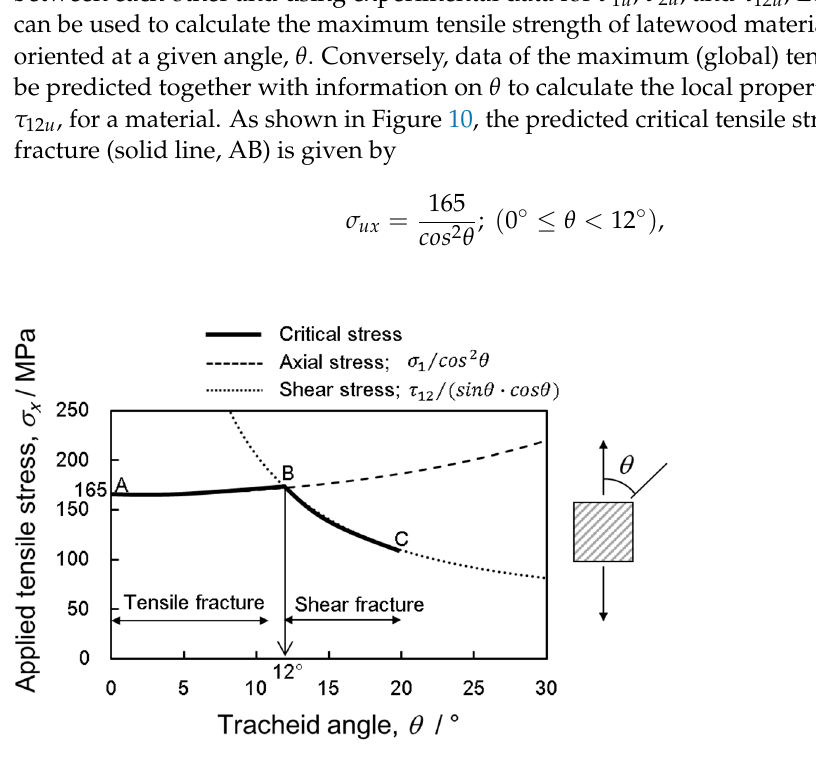
Figure 10. Predicted critical tensile strength depending on angle, θ , of the applied stresses for the onset of two failure modes.